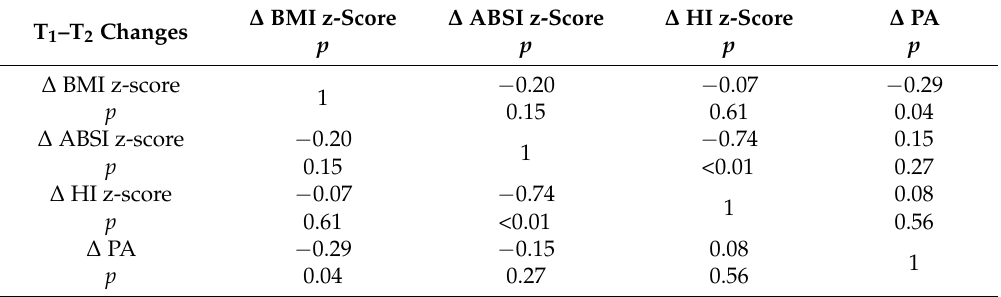
Table 3. Correlation among variations registered at follow-up in anthropometric indices and PA